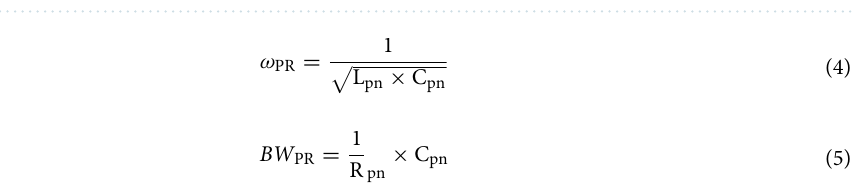
Figure 5. Equivalent circuit model of UWB